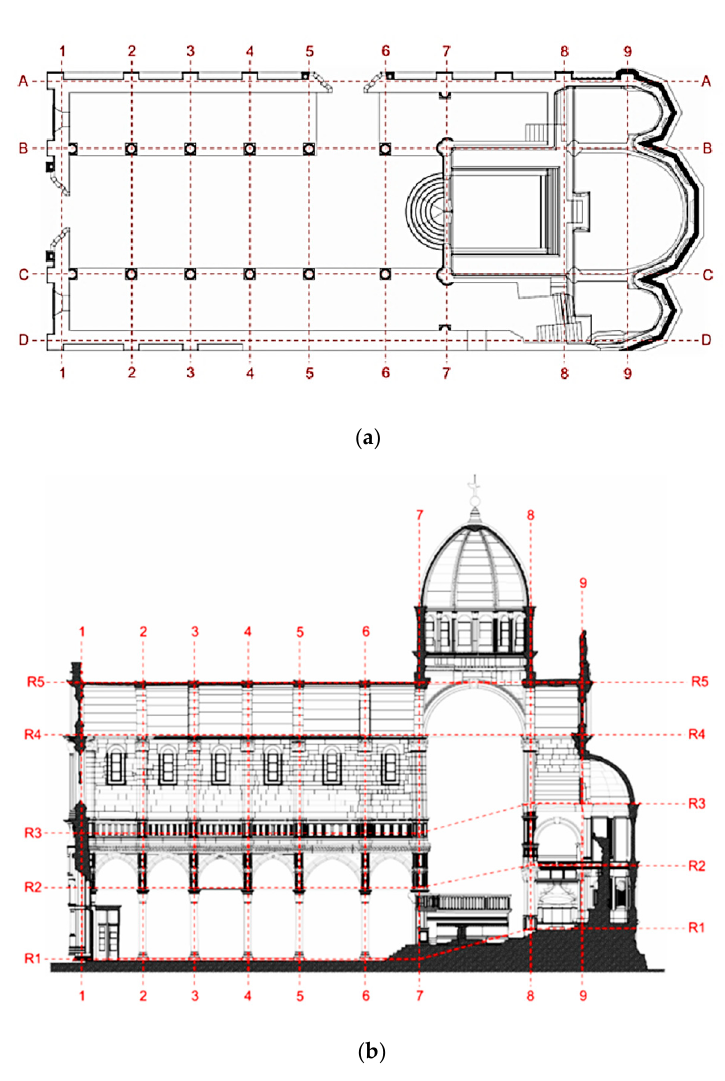
Figure 7. Cathedral of St. James in Šibenik. ( a ) Ground floor and ( b ) cross-section.